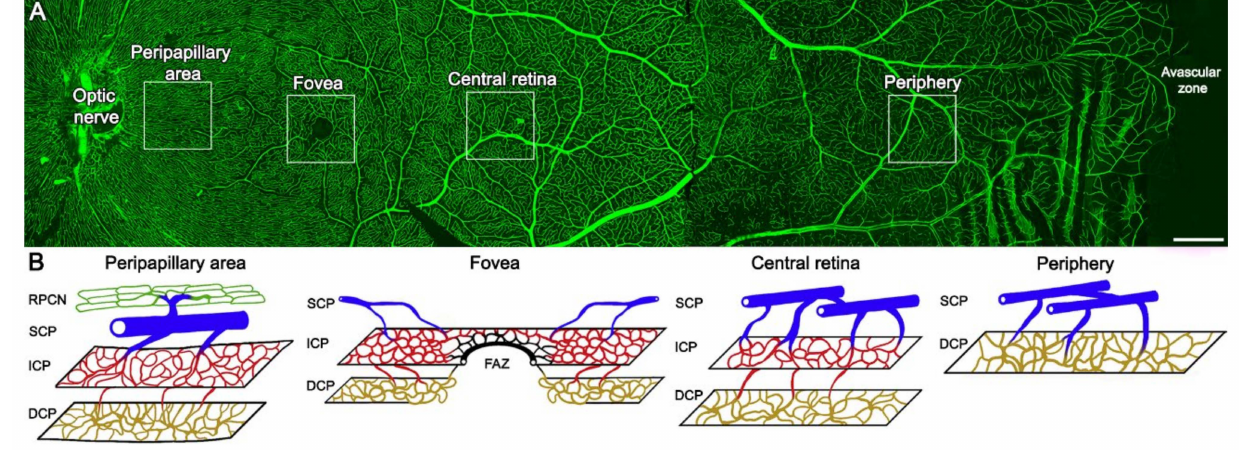
Figure 1. Morphological changes in the vascular plexuses throughout the human retina. ( A ) Whole- mount human retina immunostained with an antibody against collagen type IV showing the vascular network from the optic nerve to Ora serrata . ( B ) Drawings of the different plexuses corresponding to the insets in ( A ). Four plexuses can be observed in the peripapillary area (RPCN, SCP, ICP, and DCP) close to the optic nerve. The central retina is composed of three plexuses (SCP, ICP, and DCP), except in the fovea where the foveal avascular zone (FAZ) exists. Only two plexuses (SCP and DCP) are present in the far-periphery area. RPCN, radial peripapillary capillary network; SCP, superficial capillary plexus; ICP, intermediate capillary plexus; DCP, deep capillary plexus. Scale bar: 1